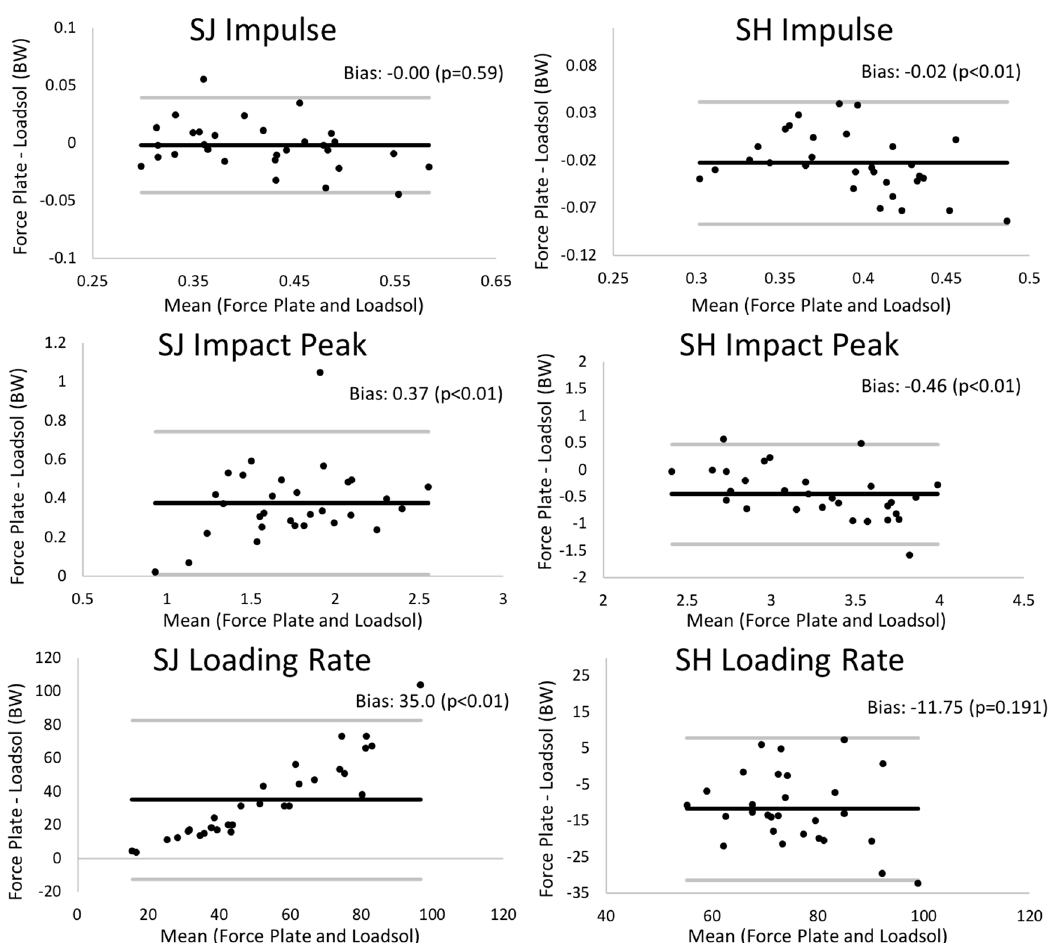
Figure 2. Bland–Altman plots showing the validity of the insole sensors at 100 Hz relative to the force plate. Note: on the plot, the bias (mean difference) and significance (paired t -test) of this bias are shown for each measure for both the stop jump (SJ) and single hop (SH) tasks. The bold black line on plots represents the mean bias, and the thin gray lines on plots are the limits of agreement (mean bias ± 1.96 SD of bias).